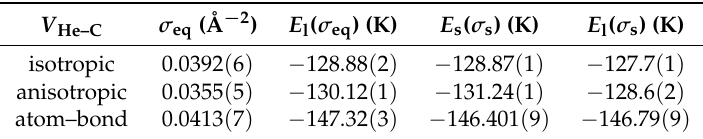
Table 2. Corresponding data to Figure 5. Results are shown for the three helium–carbon (He–C) potentials V He–C under